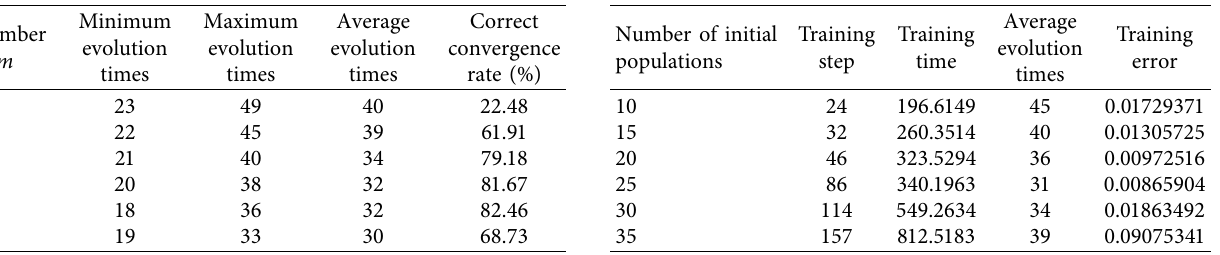
Table 3: Training parameter corresponding to different